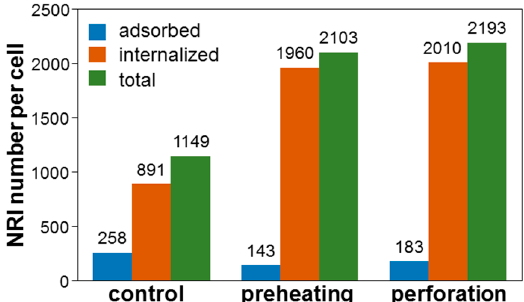
Figure 12. ICP-MS data for the number of NRIs per cell through the perforation and preheating processes when NRI-AlPcS was incubated with cells.